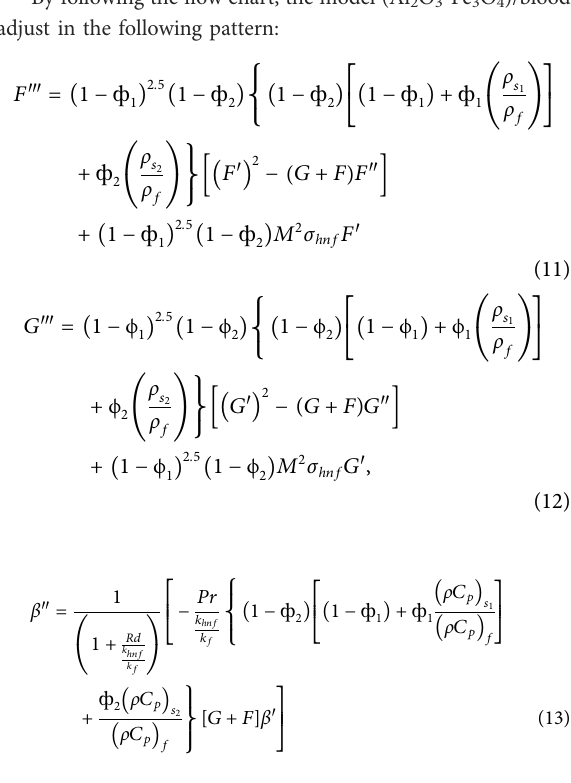
(cid:11)(cid:11)(cid:11)(cid:11)(cid:11)(cid:11) ! (cid:2) ( 2 − σ v ) λ p λ a ] − 1 (slip parameter). f 0 σ v 1